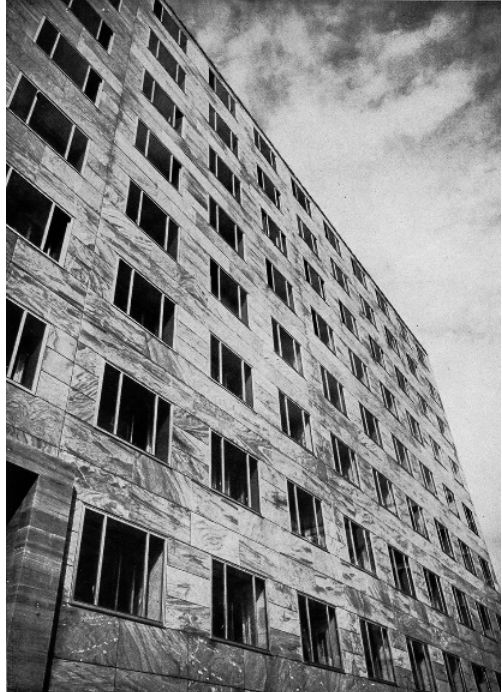
Figure 20. Montecatini office building by Gio Ponti. Milan (1936–1938). Side elevation. Cladding in cipollino apuano marble. Double Anticorodal frames. Photo form (Diotallevi and Marescotti 1939, p. 113).